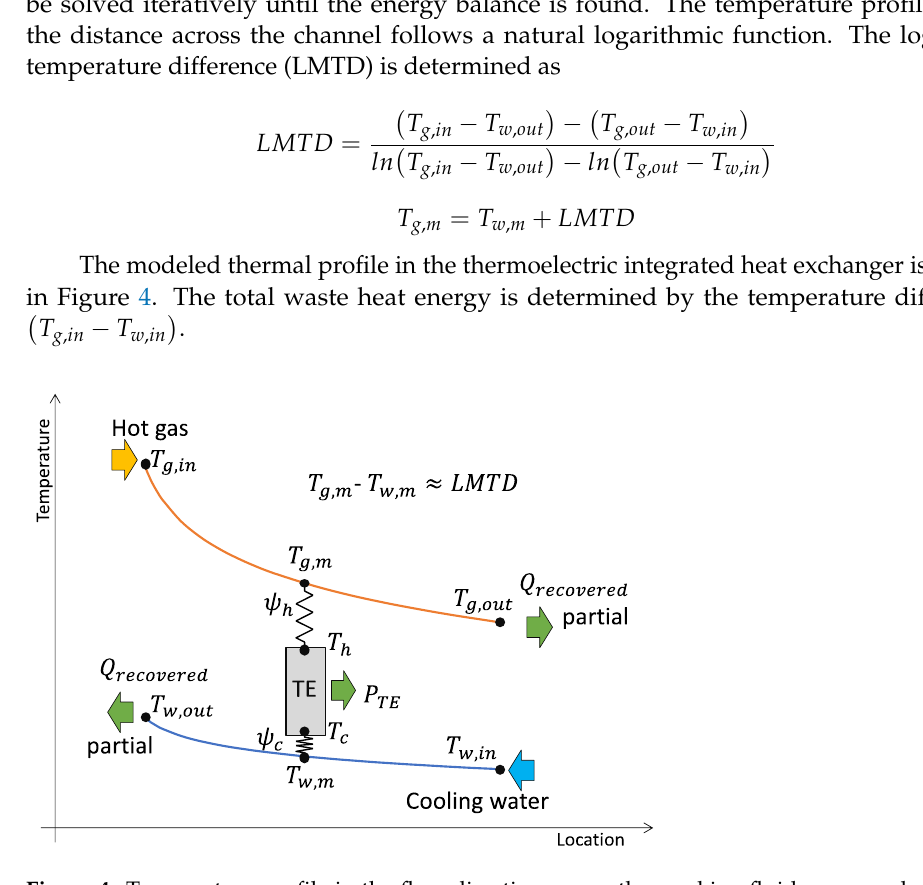
Figure 4. Temperature profile in the flow direction across the working fluid passage channels in the thermoelectric integrated heat exchanger. The LMTD helps to quantify the reference temperature of hot gas and water flows. There are ways to harvest heat energy either from exit gas, warmed up water, or both.